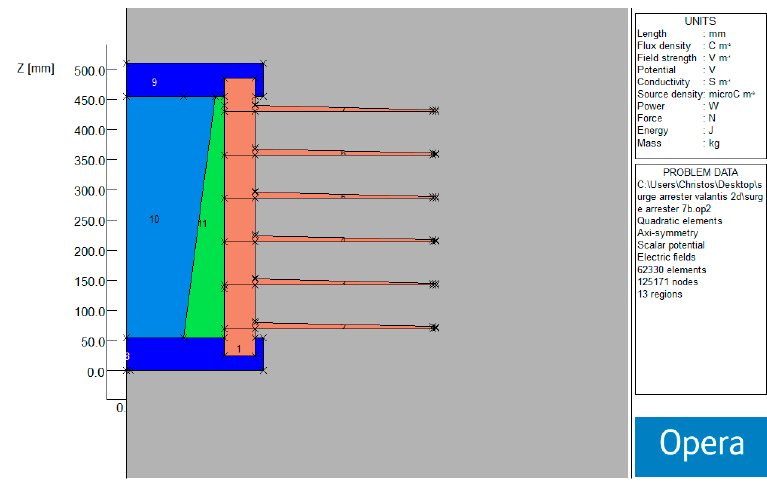
Figure 6. Arrester’s model with non uniform increase of the varistor’s diameter (case 1).